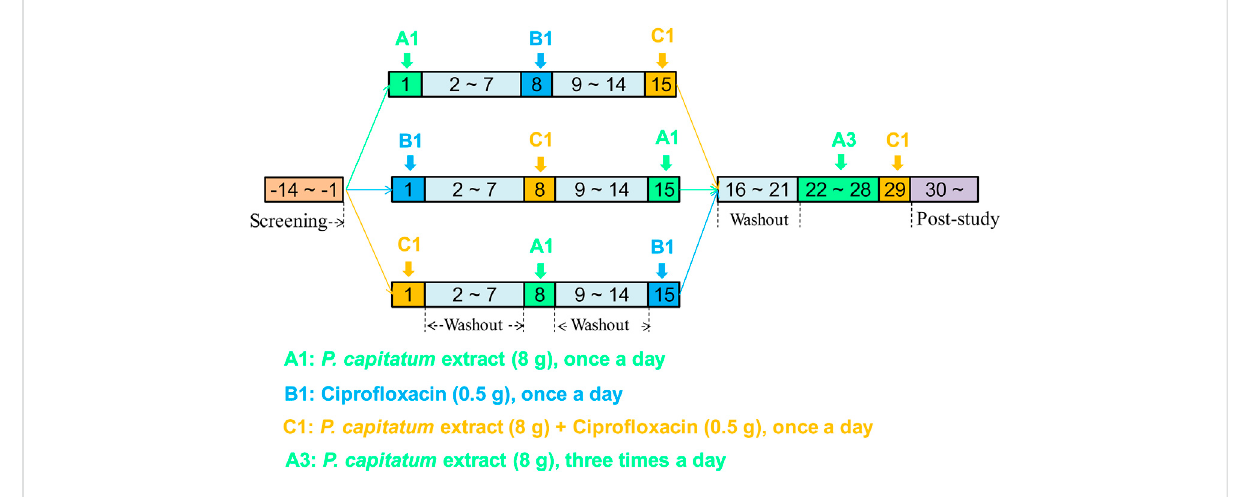
FIGURE 1 Schematic illustration of the study design in healthy